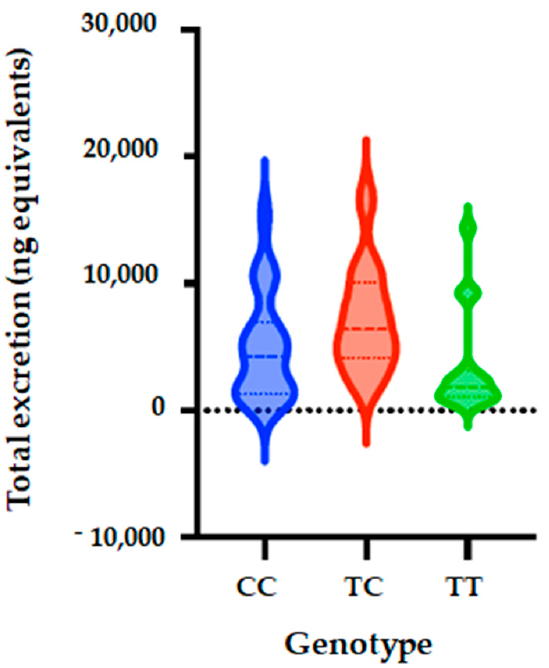
Figure 3. Total metabolite concentrations in urine depending on genotypes of SULT1A1_rs4788068 (B) polymorphism. Bars in the box show the first quartile, the third quartile, and median and whisker charts represent the minimum to maximum values. Table 9. Genotypes and allele frequencies of SULT1A1_rs1402467 polymorphism in studied population.